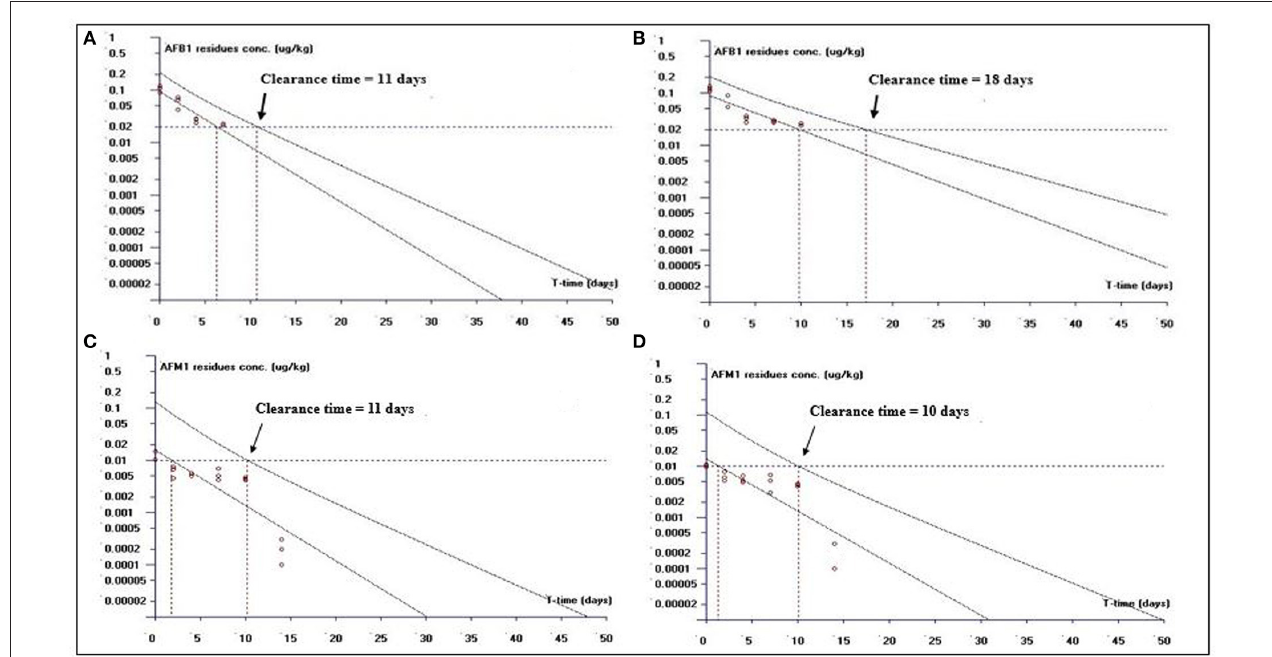
FIGURE 1 | The representative semi-logarithmic plot shows aflatoxin B1 (AFB1) and aflatoxin M1 (AFM1) residue concentrations for broiler liver tissues vs. time , with the one-sided 95% upper tolerance limit in AFB1-fed group; (A) AFB1 residues (C) AFM1 residues and in curcumin + AFB1-fed group; (B) AFB1 residues